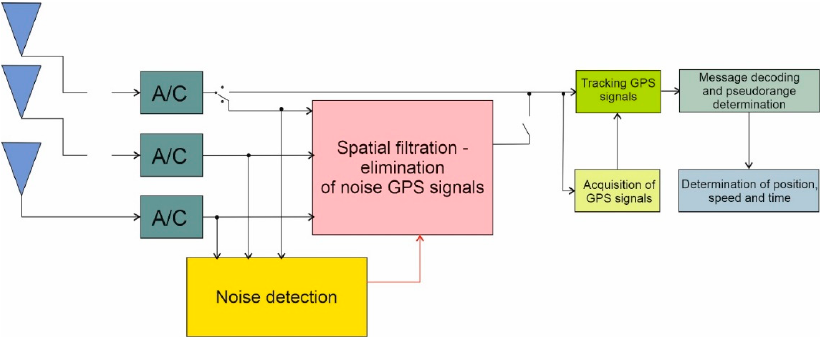
Figure 2. Block diagram of a GPS receiver with an anti-noise system.